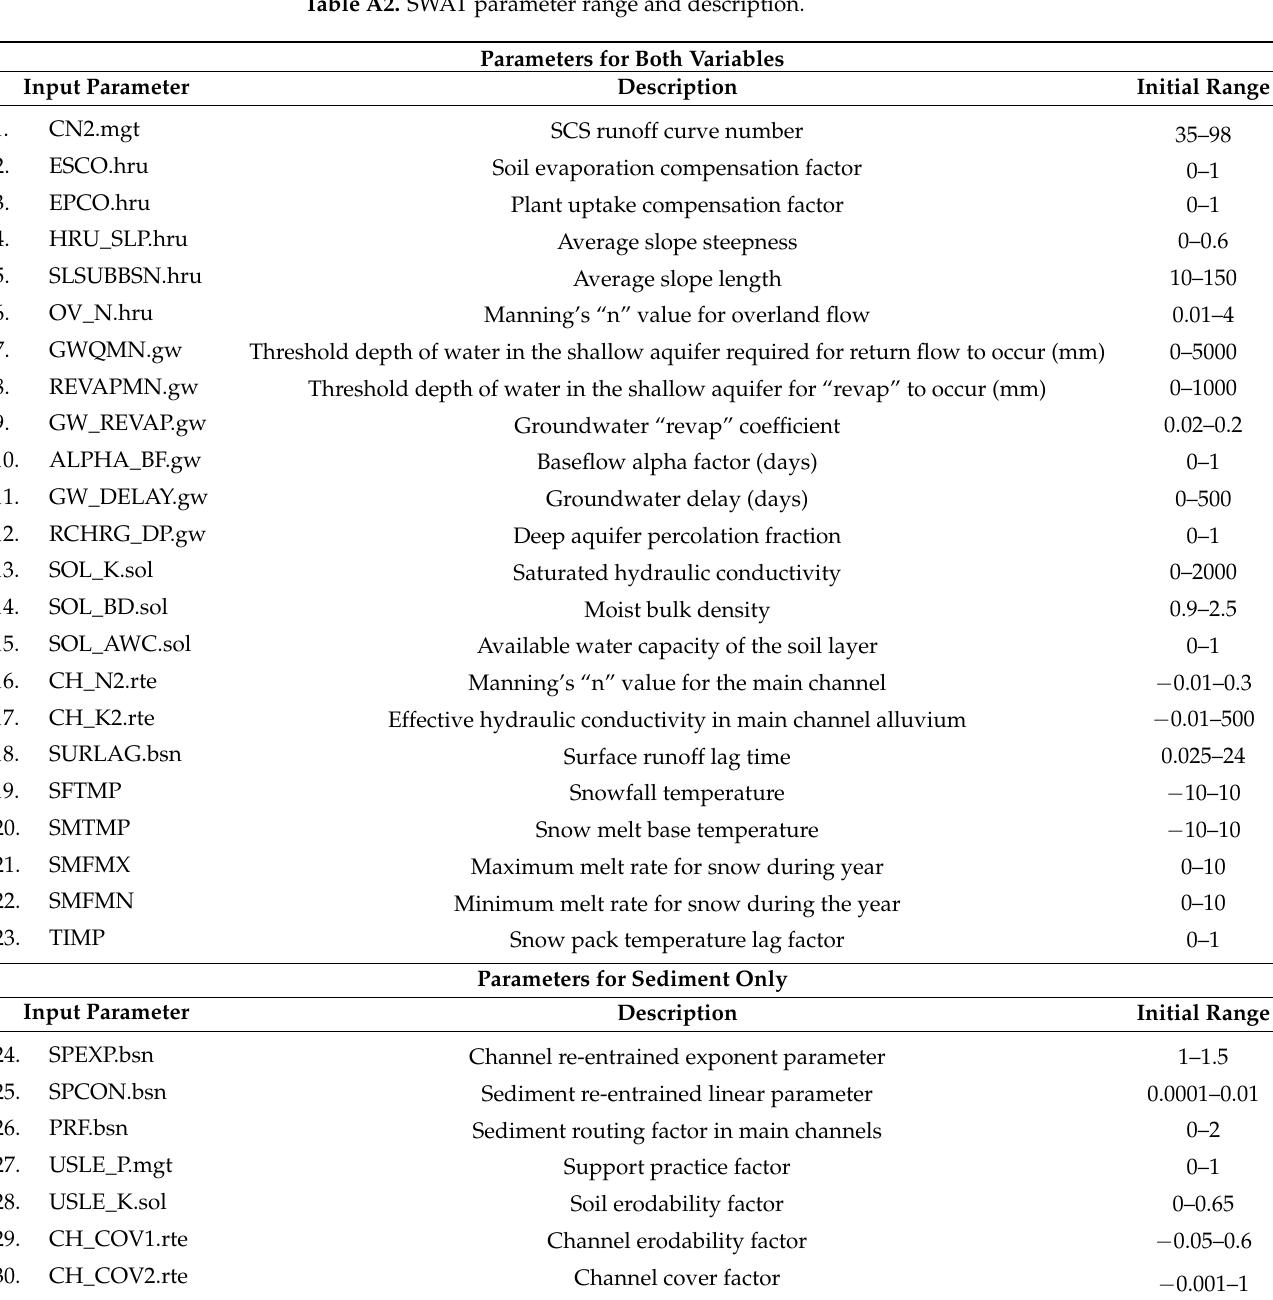
Table A2. SWAT parameter range and description.